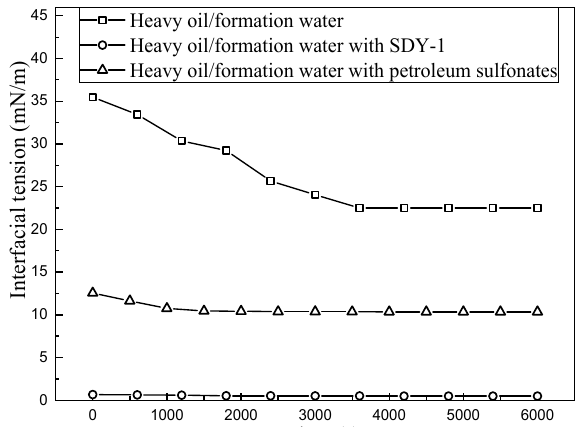
Figure 8. The variations in interfacial tension with different surfactants.